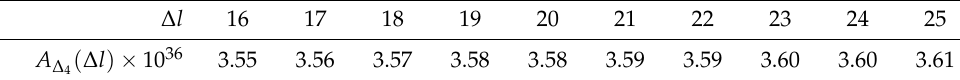
Table 2. Numerical values of the amplitude A ∆